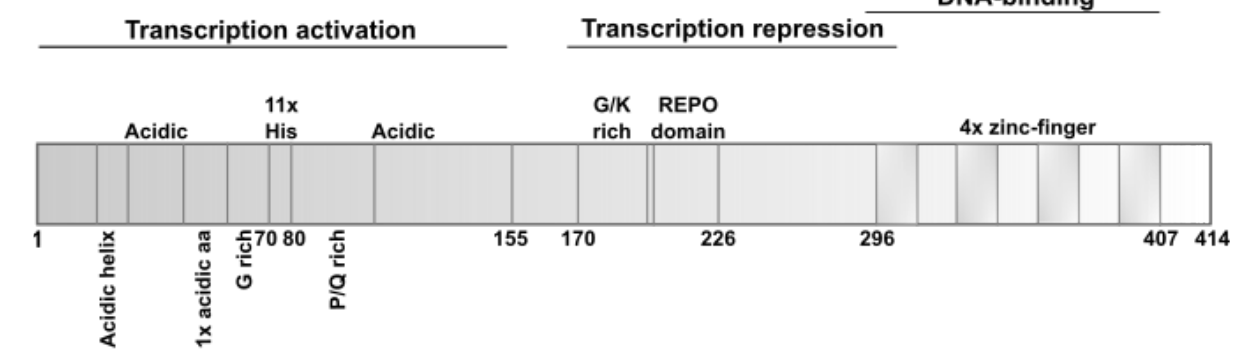
Figure 1. Schematic representation of the YY1 domains. A transactivation domain was recognized at the N terminus (1 – 155 aa) of YY1 protein. This activity is mediated by the acidic amino acid residues of the amphipathic, negatively charged helix (16 – 29 aa), 11 consecutive acidic residues (43 – 53 aa), glycine-rich motif (G-rich, 54 – 69 aa), and proline/glycine-rich motif (P/Q-rich, 80 – 100 aa). Between them, there is a histidine tract with 11 histidine residues (70 – 80 aa) responsible for nuclear accumulation and YY1-mediated RNA metabolism. In the central sequence, a slightly overlapping C terminus is located in the transcription repression domain. This domain includes the glycine/alanine-rich region (G/A-rich, 154 – 170 aa) that mediates DNA interaction and, together with glycine/lysine-rich region (GK-rich, 170 – 200 aa), plays role in YY1-dependent acetylation/deacetylation events of the REPO domain (205 – 226 aa) that recruits corepressors of the polycomb group protein. The C terminus consists of four zinc-finger motifs (296 – 320 aa, 325 – 347 aa, 353 – 377 aa, and 383 – 407 aa) which guarantee YY1 interaction with DNA.